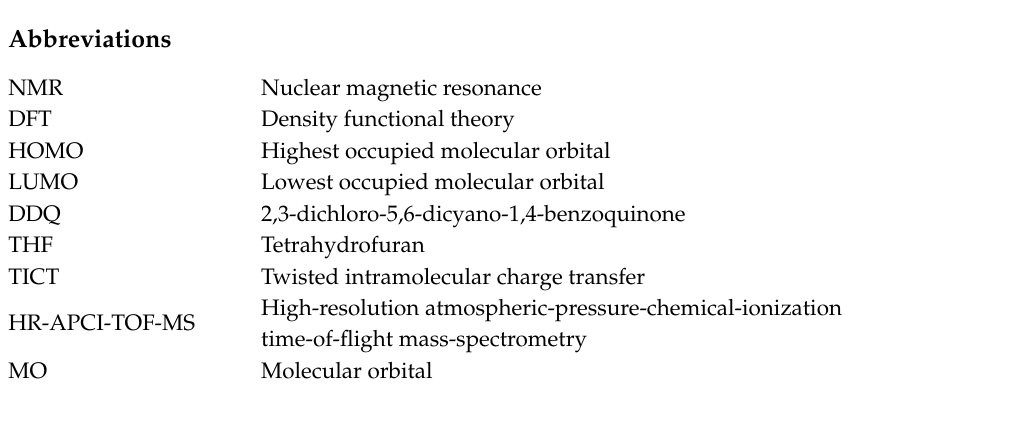
Figure S4: X-Ray structures, Figure S5: Cyclic voltammogram, Figure S6: Molecular orbital (MO) energy diagrams and Kohn–Sham orbital representations calculated at the B3LYP/6-311G(d,p) level, Scheme S7-1: Plausible reaction mechanism for the formation of 8 . Table S1: Absorption and emission details of 4 , 5 , 6H , and 7H in various solvents, Table S2: The photophysical parameters of 6H and 7H in various solvents. Table S3: Crystallographic details of 6Ag , 6H , and 8